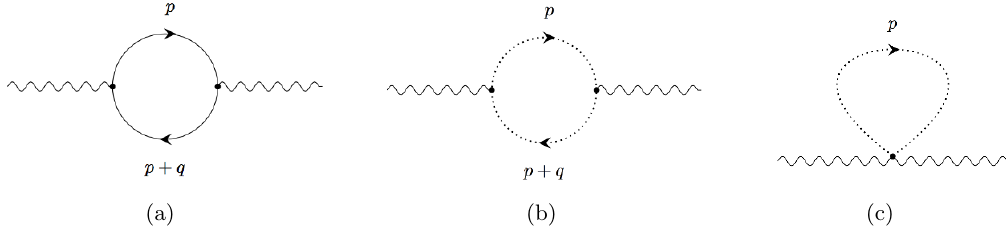
Figure 1 . The photon self-energy at